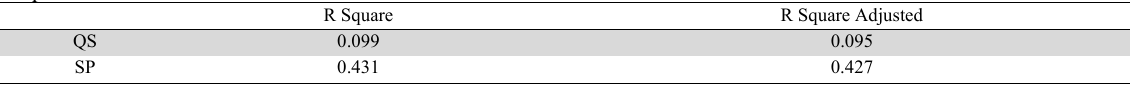
R Square R Square Adjusted